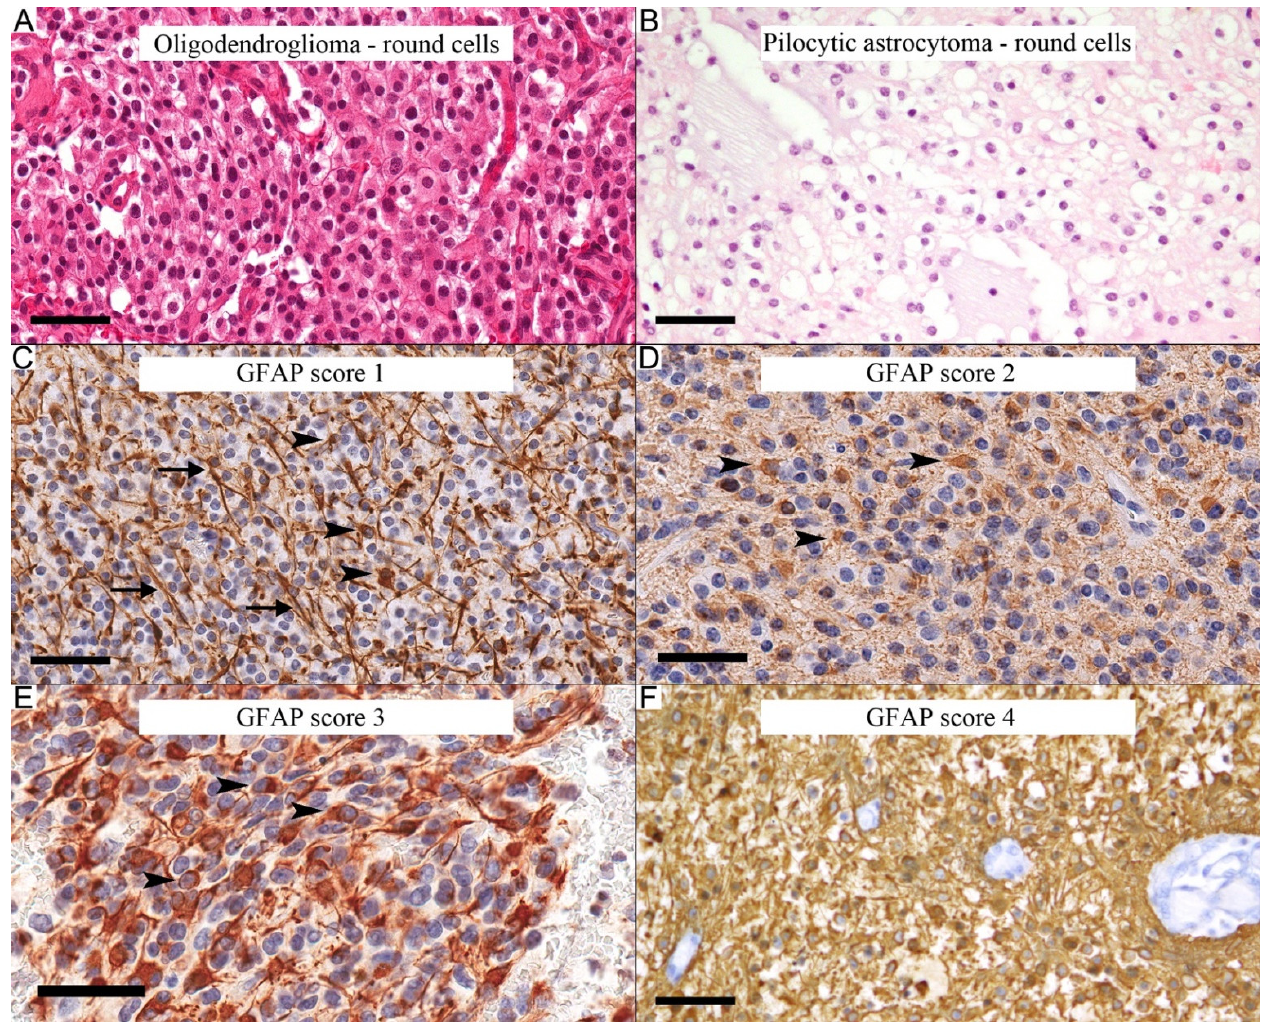
Figure 1. Definition of the oligodendrocyte-like areas and GFAP scores. ( A ) Oligodendroglioma with round neoplastic cells. ( B ) Oligodendrocyte-like area in pilocytic astrocytoma. GFAP scoring system ( C – F ). ( C ) Score 1: GFAP-staining cells in less than 25% of neoplastic cells. Most stained cells here are reactive astrocytes (arrows), whereas most neoplastic cells are negative (arrowheads). ( D ) Score 2: GFAP-staining cells in 25–50% of the neoplastic cells. ( E ) Score 3: GFAP staining in 50–75% of the neoplastic cells (arrowheads). ( F ) Score 4: GFAP staining in more than 75% of the neoplastic cells. Scale bars: 50 µm ( A – F ).